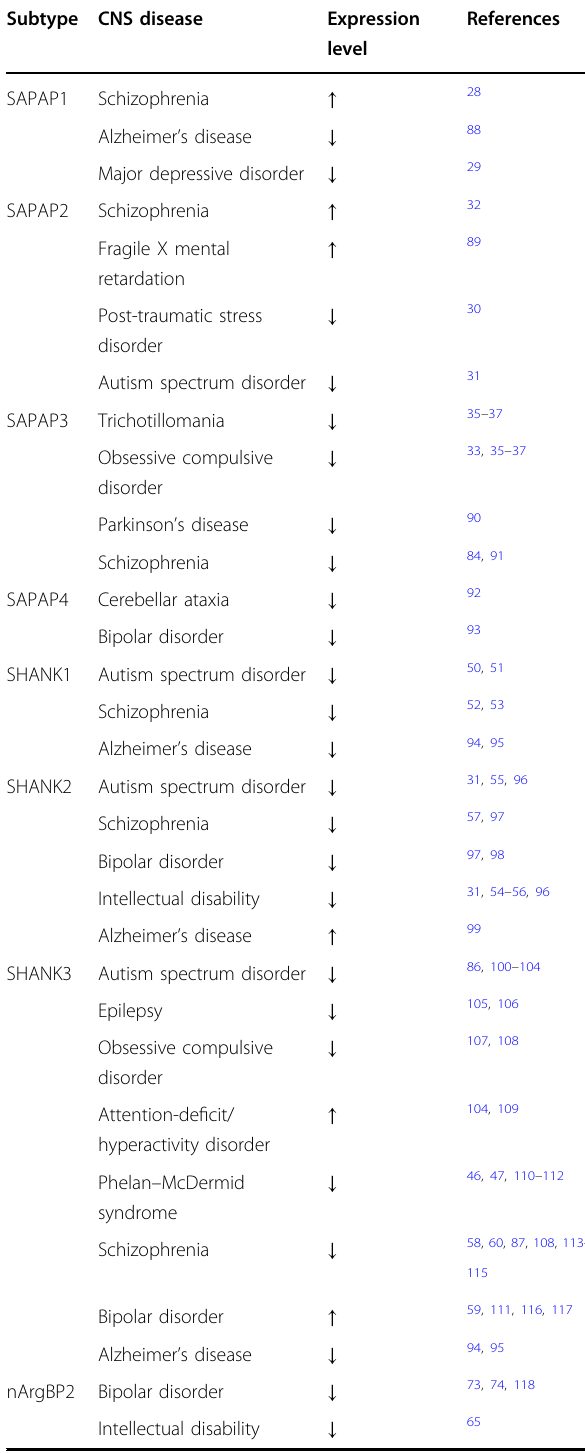
Table 1 Table showing the SAPAP, SHANK,